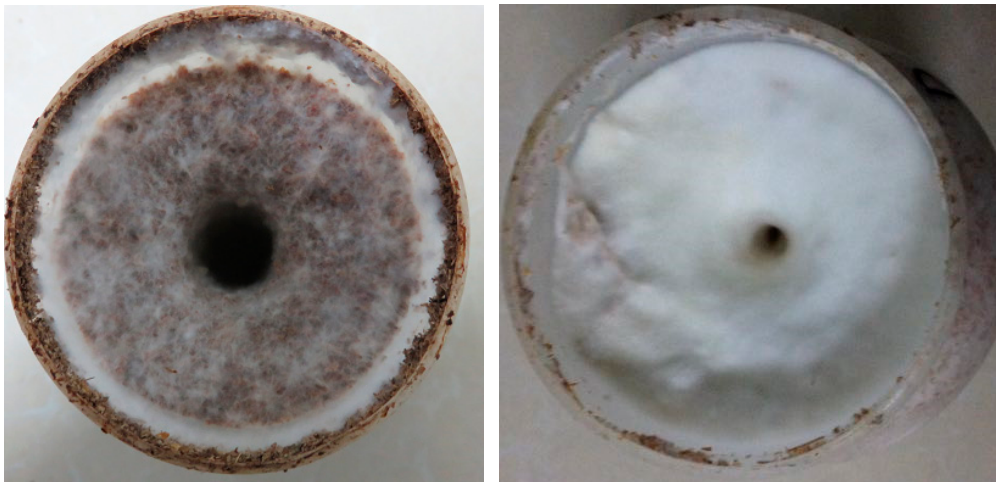
Figure 1. The morphological characteristics of immature mycelia (Left image) and mature mycelia (Right image).